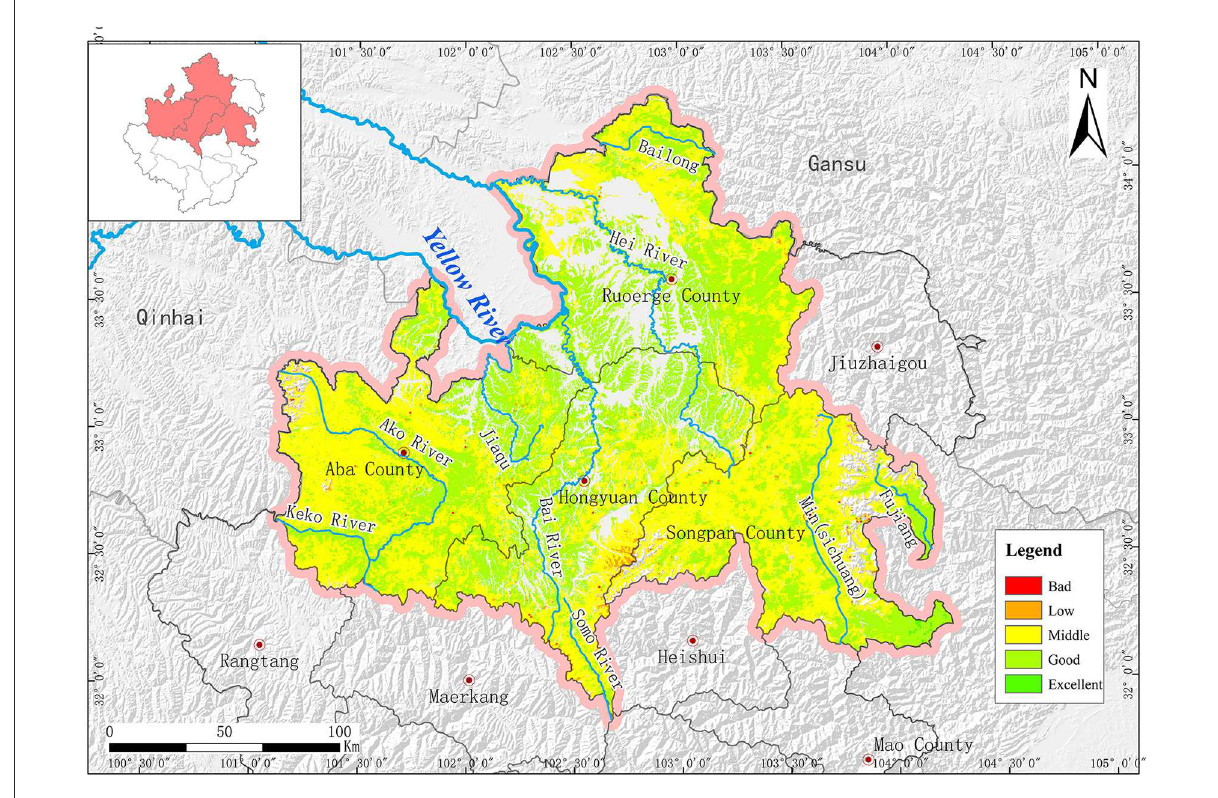
FIGURE10 Ecosystem quality